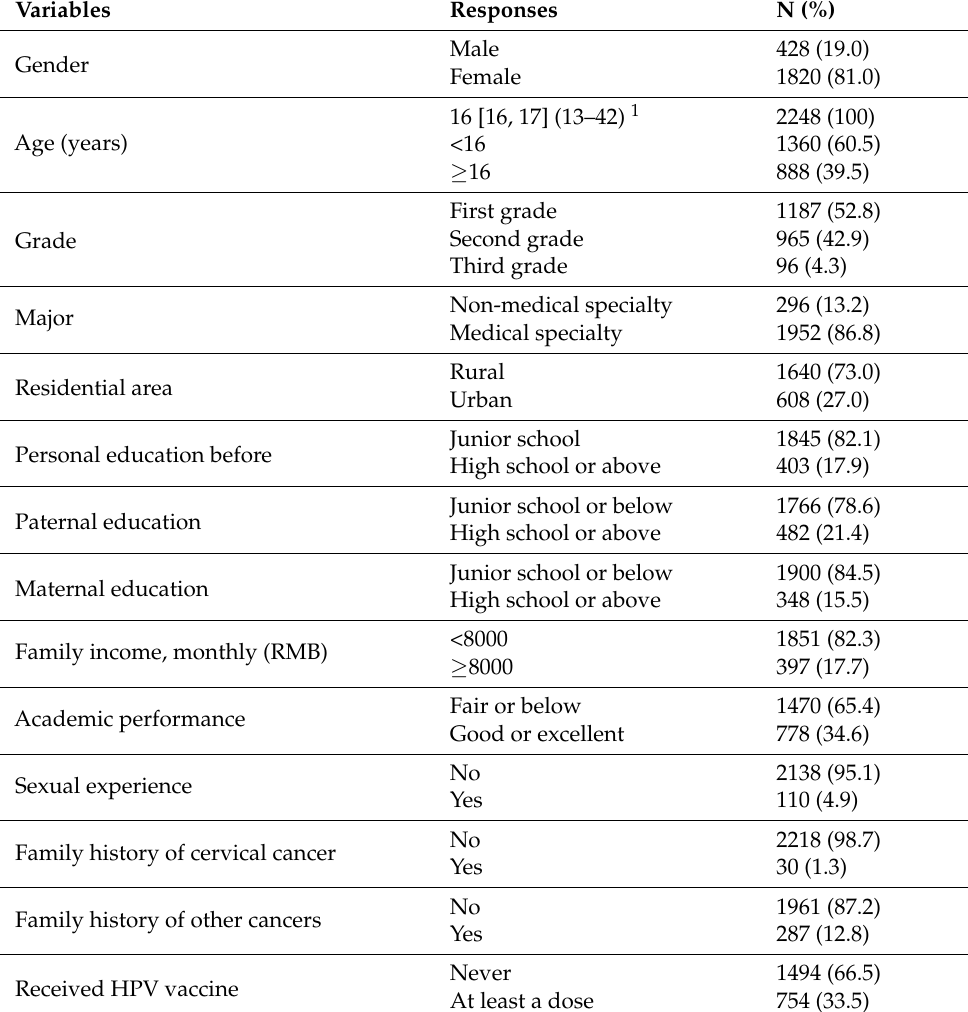
Table 1. Socio-demographic characteristics of the study respondents ( n =